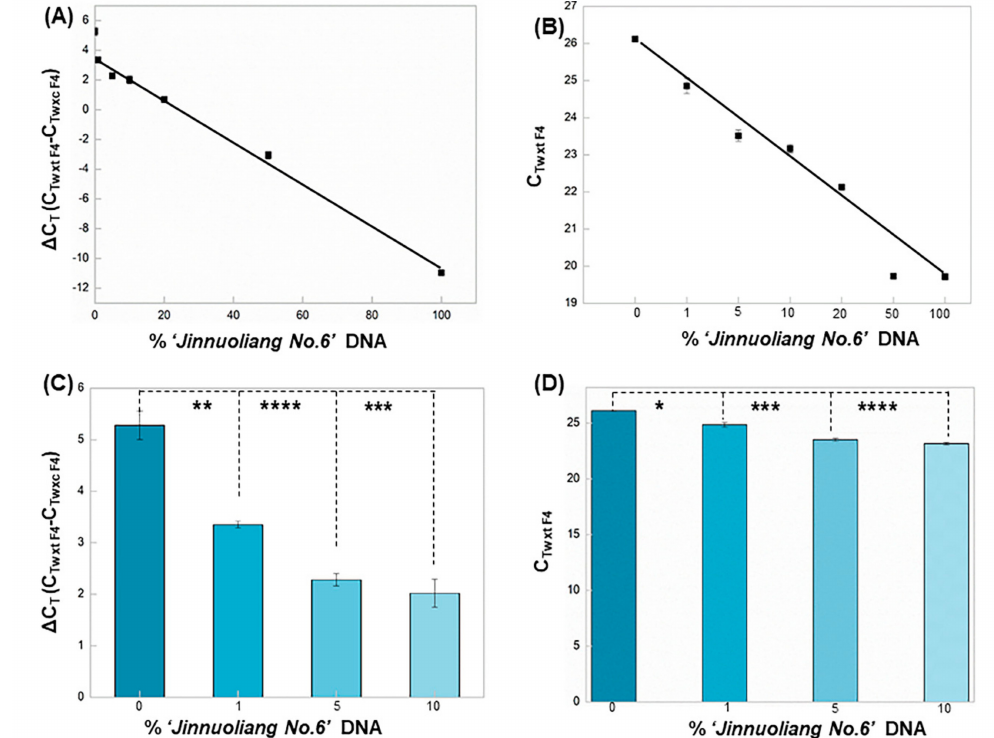
Figure 3. Quantitation of adulteration of aAMRS-PCR. ( A ) The relationship between ‘Jinnuoliang No.6 (cid:48) with different content ratios (0%, 1%, 5%, 10%, 20%, 50%, 100%) and ∆ CT (CTwxt F4-CTwxc F4). ( B ) The relationship between ‘Jinnuoliang No.6 (cid:48) with different content ratios (0%, 1%, 5%, 10%, 20%, 50%, 100%) and CTwxt F4. ( C ) ∆ CT (CTwxt F4-CTwxc F4) of ‘Jinnuoliang No.6 (cid:48) with low content ratios (0%, 1%, 5%, 10%). ( D ) CTwxt F4 value of ‘Jinnuoliang No.6 (cid:48) with low content ratios (0%, 1%, 5%, 10%). Statistical significance data were obtained by two-tailed unpaired student’s t -test: * p < 0.05, ** p < 0.01, *** p < 0.001, **** p <